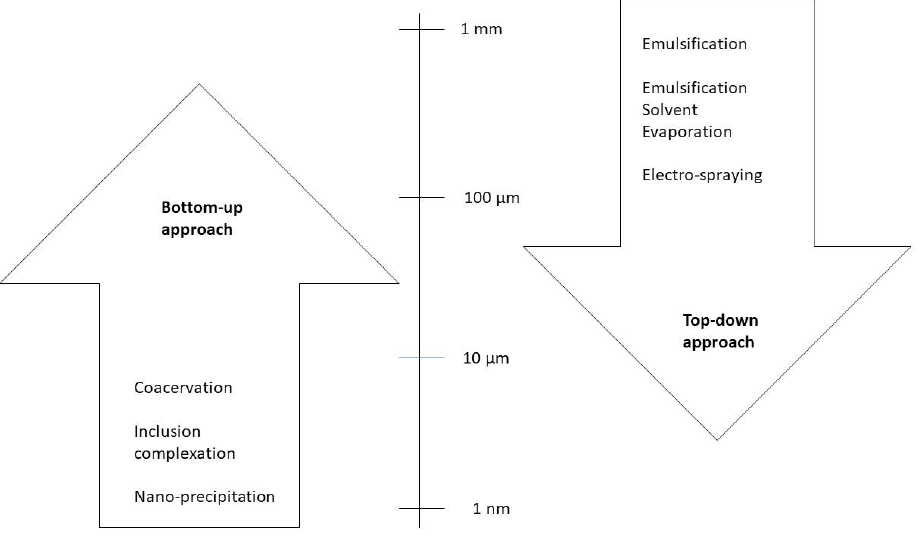
Figure 2. Size of the micro- and nanocapsules (adapted with permission from [39]. Copyright 2017, Elsevier).